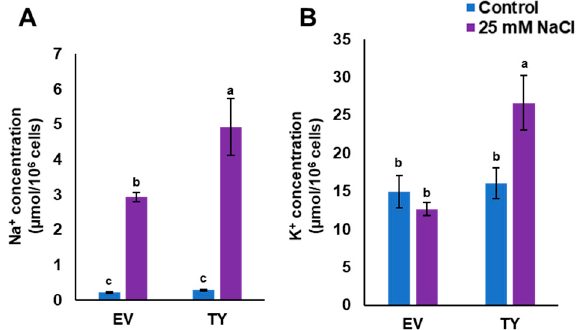
Figure 7. Accumulation of Na + and K + in transgenic yeast cells. Na + ( A ) and K + ( B ) concentrations in TY or EV when grown in liquid synthetic media (LSM) (control) and LSM supplemented with 25 mM NaCl as salinity stress conditions. The bars represent the mean concentration of Na + and K + (± SE, n = 3), while the asterisks indicate a significant difference to wild type (WT) at p < 0.05.